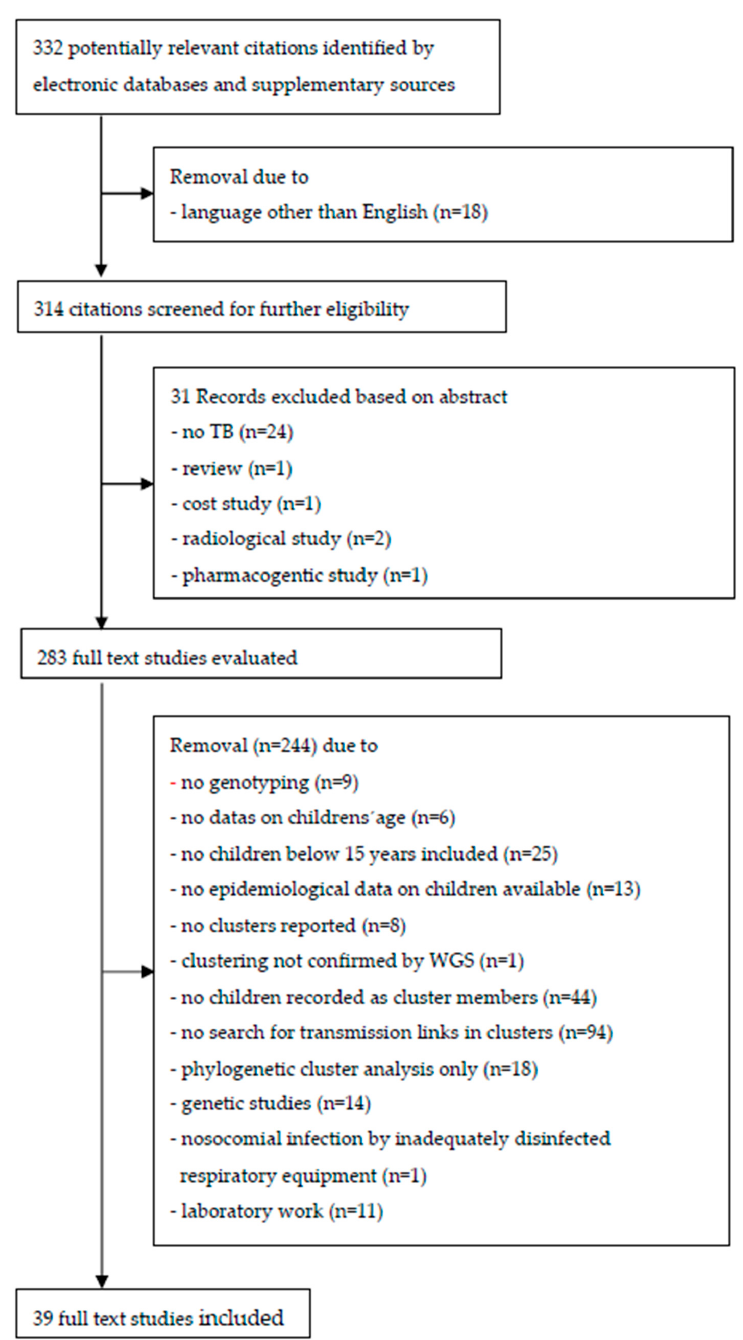
Figure 1. PRISMA flow diagram of study selection.